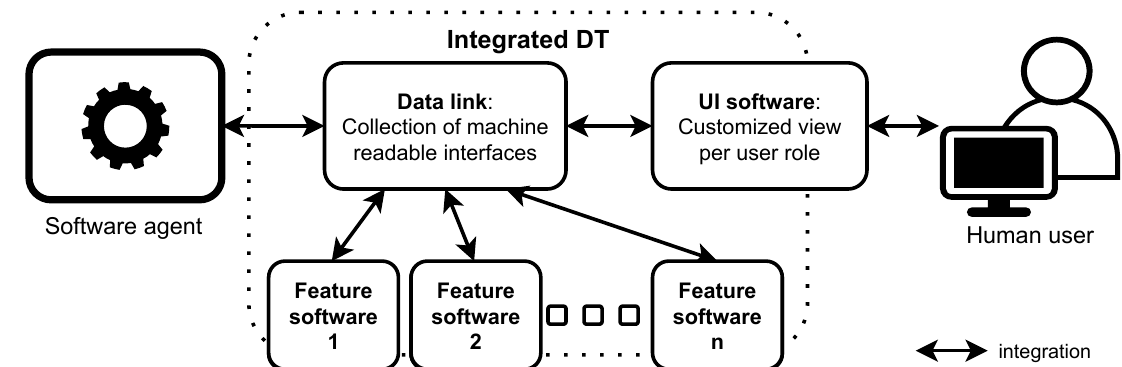
Figure 11. Services and users of an integrated digital twin. The data link is not software at its core but is made available via software. “Feature software” blocks represent the features of feature-based digital twin framework (FDTF). The figure does not depict the connection to the real-world entity, which is fulfilled by one or many “Coupling” feature software